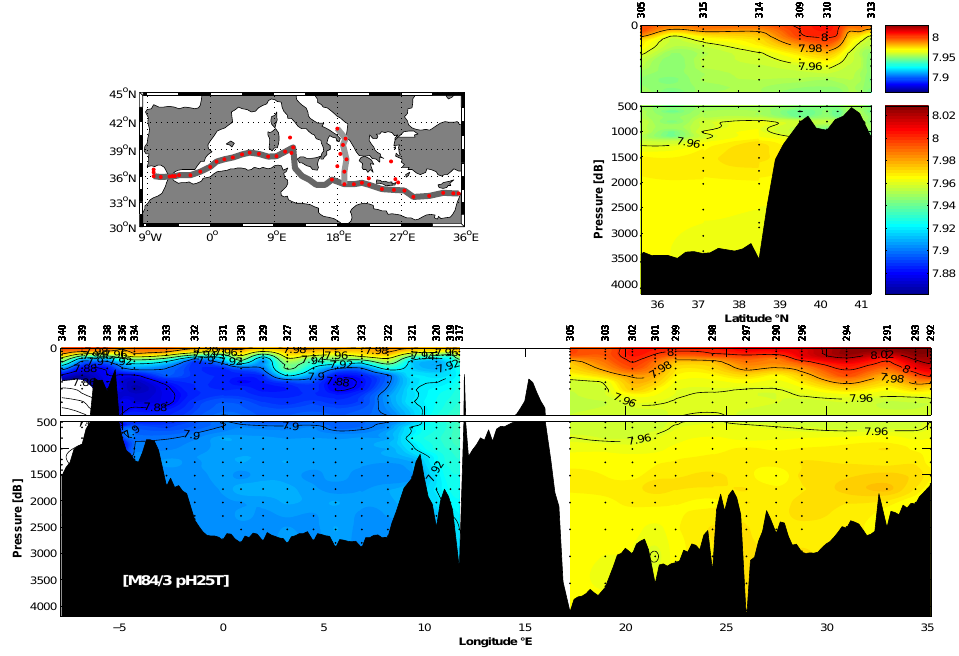
DIC > 2310 µmol kg − 1 , but no clear signal in pH which varies between 7.96 and 7.98 (Figs. 5, 6 and 7). In the western basin LIW was found around 500 dbars as a maximum in salinity, corresponding to TA ( ≈ 2590 µmol kg − 1 ) (Fig. 5), maximum in DIC ( ≈ 2330 µmol kg − 1 ) (Fig. 6) and minimum pH25T ( ≈ 7.9) (Fig. 7). In the eastern basin, the maximum layer of remineralization, indicated by the oxygen minimum (see Fig. 6 in Tanhua et al., 2013a), was lo- cated below LIW while in the western basin, both co-